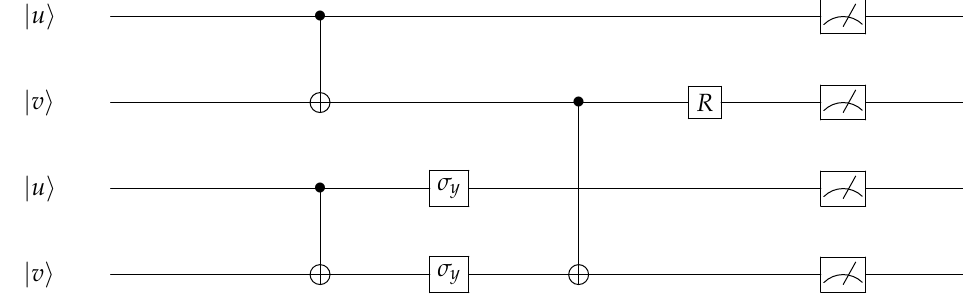
Figure 4. The circuit model of M z operator using Romero et al. [54] protocol for implementing the operator D